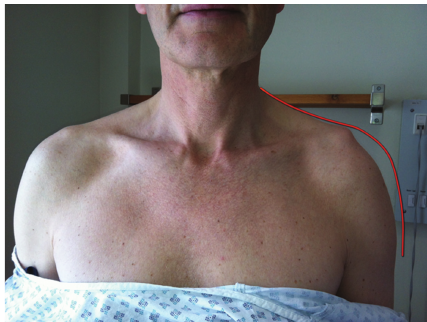
Figure 7: Axillary view radiograph taken 3 weeks after initial injury.